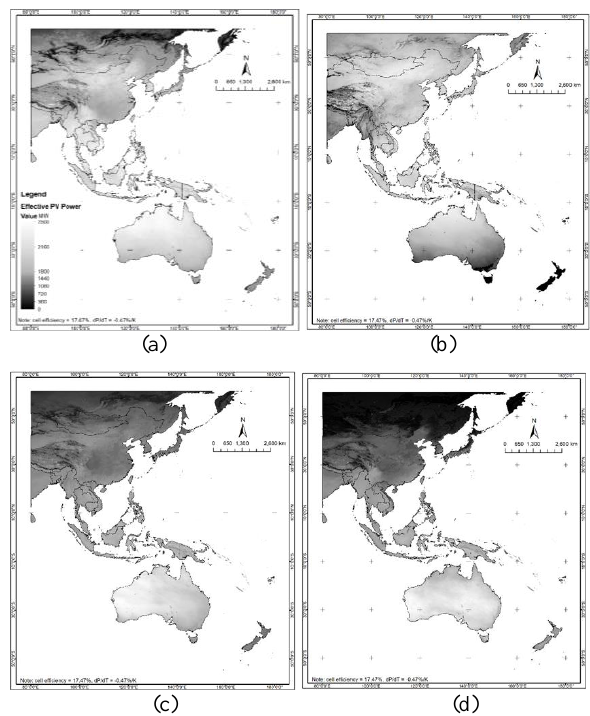
Figure 7. Effective mean seasonal PV power ( P’ PV ) (in megawatts) considering the effects of temperature, dust and snow in the Asia Pacific region: (a) MAM; (b) JJA; (c) SON; (d) DJF.